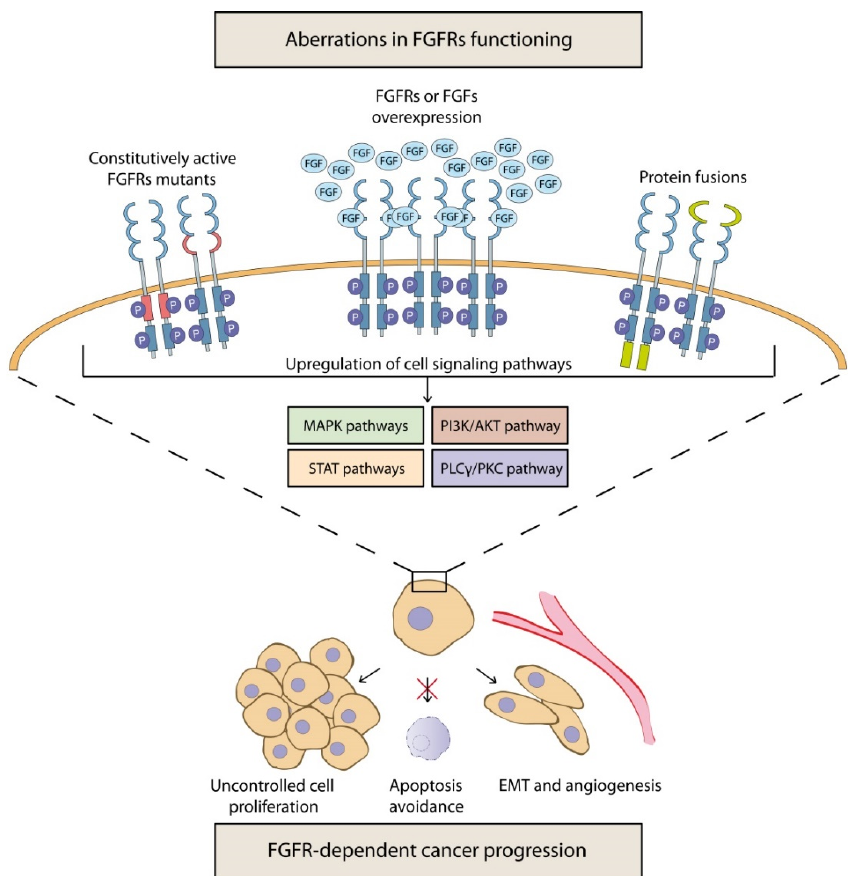
Figure 1. FGFRs-mediated mechanisms of cancer development and progression. Fibroblast growth factor receptors (FGFRs) and their natural ligands (FGFs) are involved in many biological processes, crucial for the proper operating of the cells and entire organism. However, many aberrations in FGFRs and/or FGFs genes may generate deregulations in the FGFRs/FGFs axis, which often upregulate downstream cell signaling and drive tumorigenesis. Activating mutations may lead to ligand ‐ independent receptor dimerization and activation or creating the constitutively active kinase domains. The amplification of FGFRs or FGFs genes results in protein overexpression, which may also contribute to enhanced FGFRs ‐ mediated cell signaling. Chromosomal translocations lead to the formation of fusion proteins that in some cases cause, similarly to activation mutations, receptor activation independently of FGFs presence. Regardless of the type of FGFRs dysfunction, the consequence is upregulated cell signaling that may drive cancer progression, through uncontrolled cell division, apoptosis avoidance, new blood vessel formation and/or EMT.